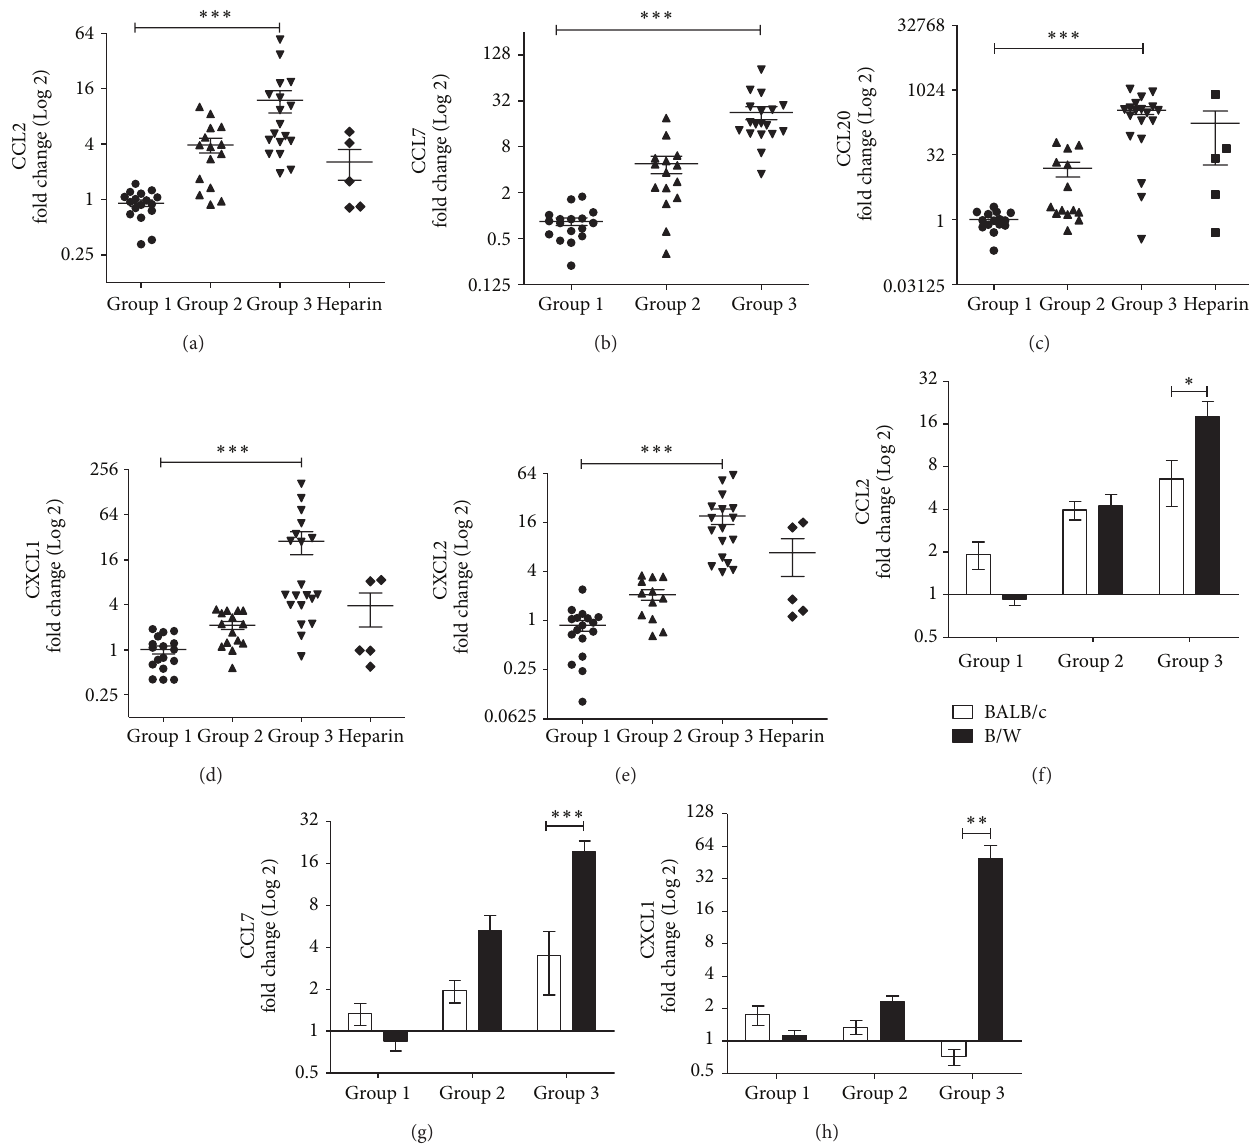
Figure 1: LMW heparin treatment does not affect chemokine mRNA expression within the kidneys of B/W mice. The mRNA expression of CCL2 (a), CCL7 (b), CCL20 (c), CXCL1 (d), and CXCL2 (e) was significantly increased in Group 3 mice and were not significantly reduced in heparin-treated mice. The mRNA expression of CCL2 (f), CCL7 (g), and CXCL1 (h) was also analyzed in age-matched BALB/c mice. Data is given as Log 2 of mean ± SEM of fold change values normalized against 4-week-old mice ( 𝑛 = 3 ). 𝑃 values are calculated using one-way ANOVA followed by Bonferroni posttest. ∗ 𝑃 < 0.05 ; ∗∗ 𝑃 < 0.01 ; ∗∗∗ 𝑃 < 0.001 . Group 1: 4–10w.o B/W mice ( 𝑛 = 17 ); Group 2: 18–30 w.o B/W mice with mesangial IC deposits without proteinuria ( 𝑛 = 15 ); Group 3: 23–36 w.o B/W mice with proteinuria ( 𝑛 = 18 ); Group 4: 31–39 w.o heparin-treated B/W mice ( 𝑛 = 5